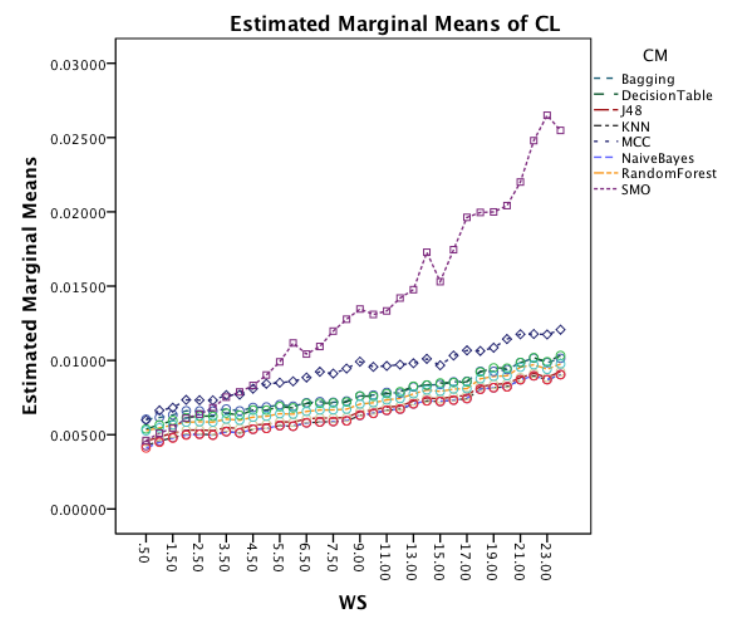
Figure 17. Two-way interaction effect for WS and CM.